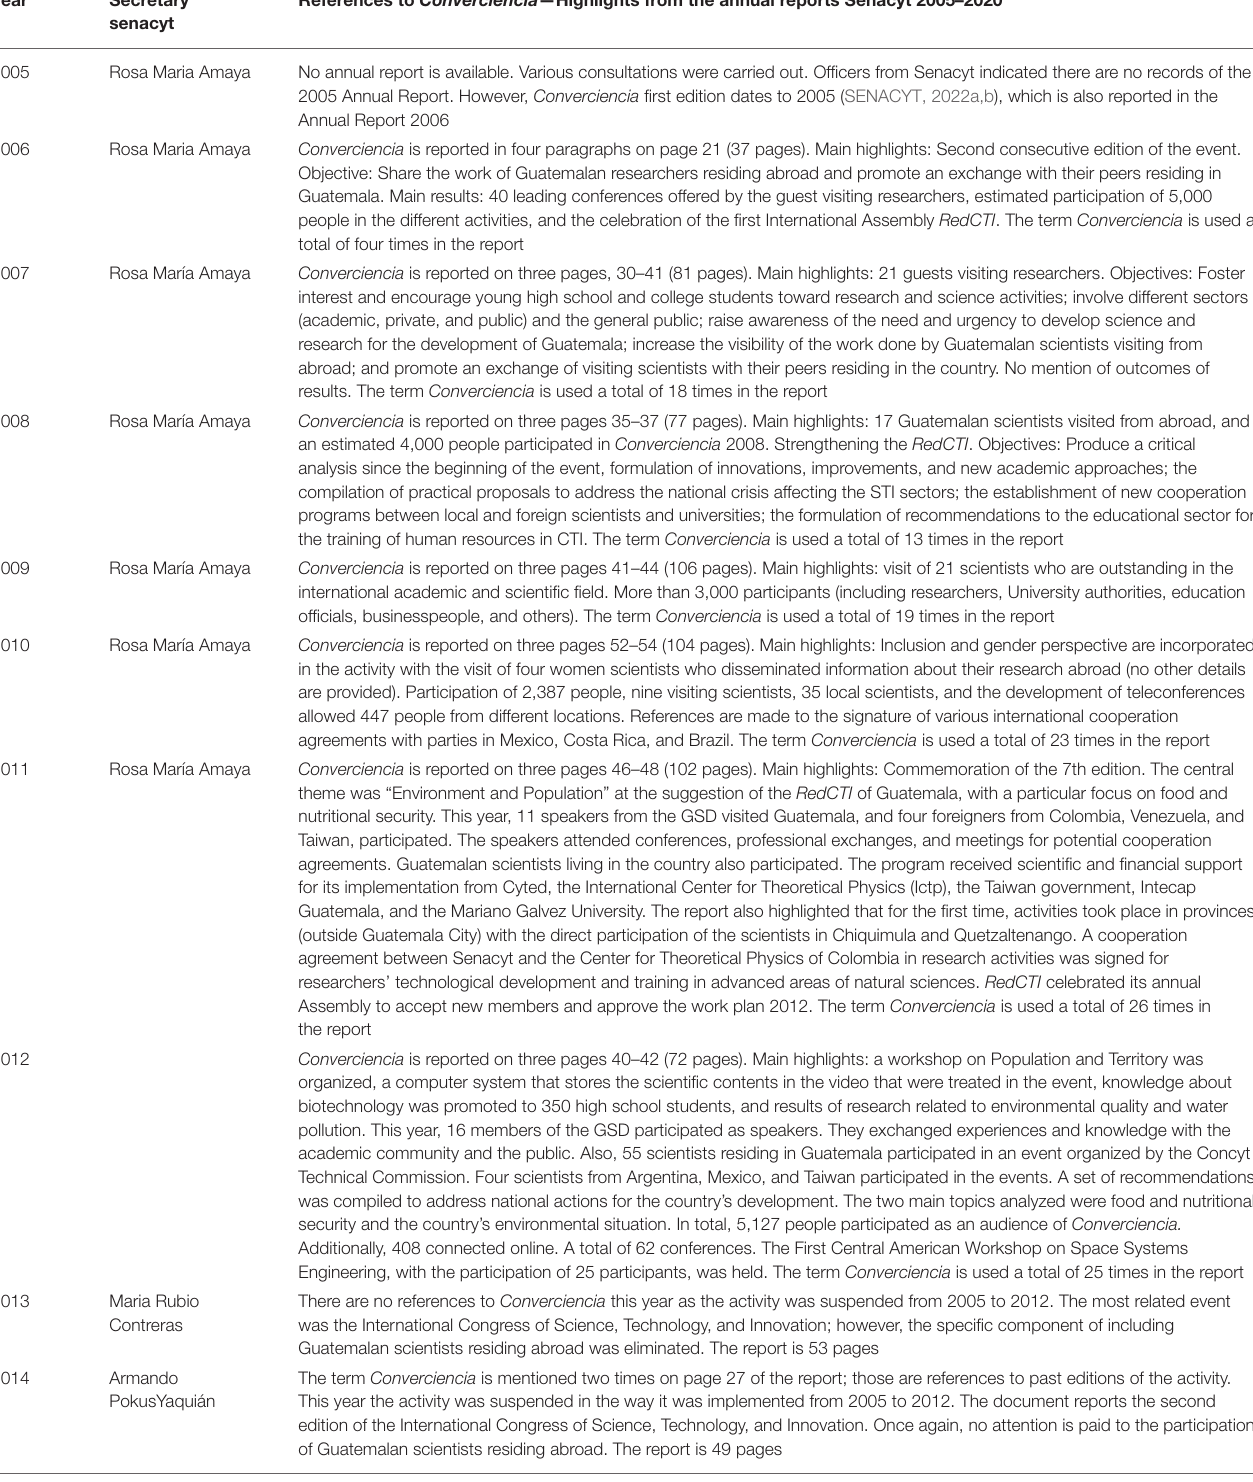
TABLE 6 | Descriptive analysis: detailed review of the annual reports, Senacyt